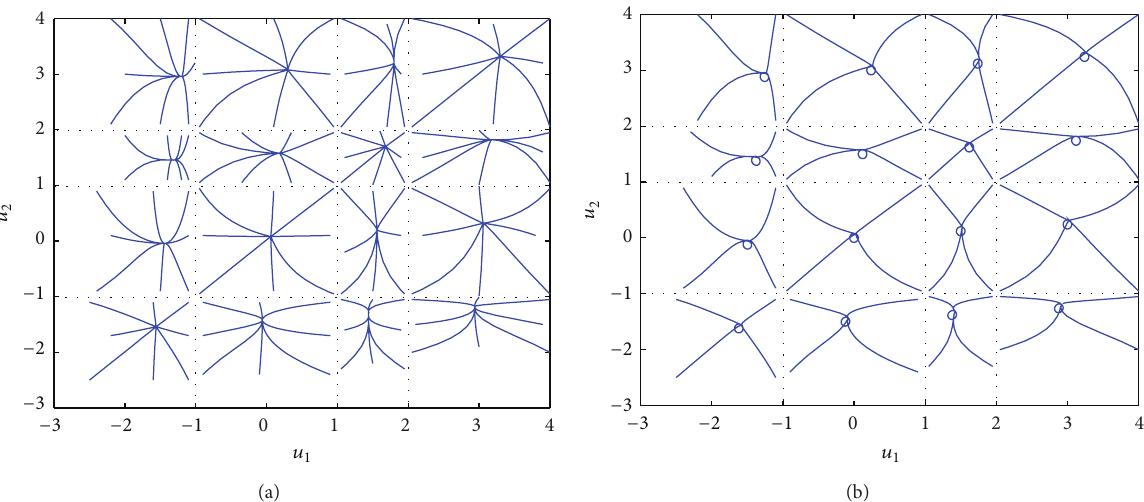
Figure 3: Transient behaviors of the state variables 𝑢 1 (𝑡) and 𝑢 2 (𝑡) with different initial values in Example 3.